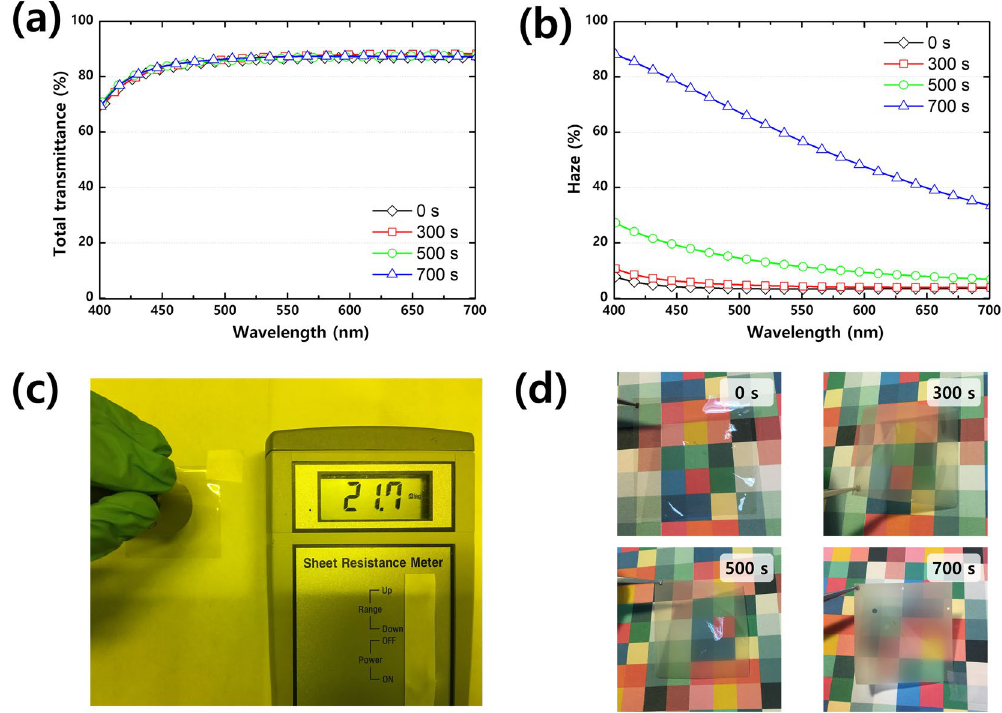
Figure 3. ( a ) Total transmittance and ( b ) haze as a function of wavelength for plasma-treated PVB/AgNW substrates (process pressure: 30 mTorr, process power: 200 W). ( c ) Sheet resistance testing of PVB/AgNW using sheet resistance meter. ( d ) Photographic images of plasma-treated PVB/AgNW films for different plasma times.